Question: Looking at the figure, what chart type is it?
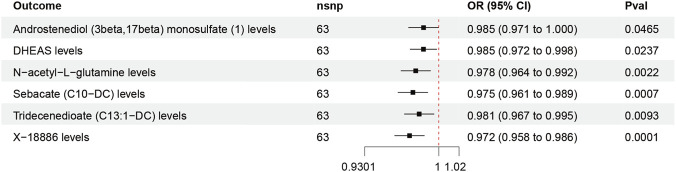
Answer: forest